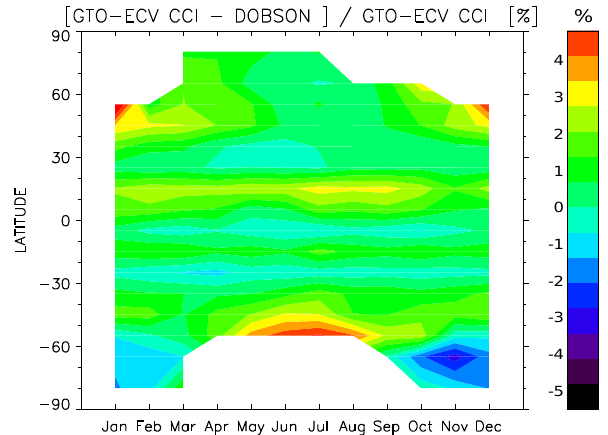
Figure 12. Seasonal variability of the GTO-ECV CCI data com- pared to the Dobson network as a contour plot of latitude vs. month of the